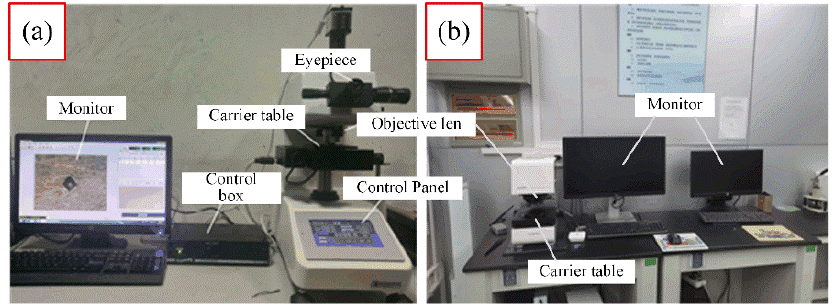
Figure 3. Measuring equipment: ( a ) MH500 microhardness tester; ( b ) 3D laser microscope.